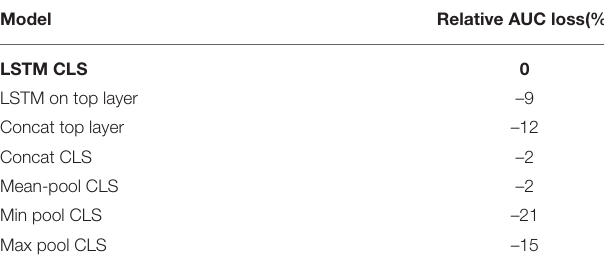
TABLE 5 | Ablation: Average performance loss across all the targets relatively to the best combination model.